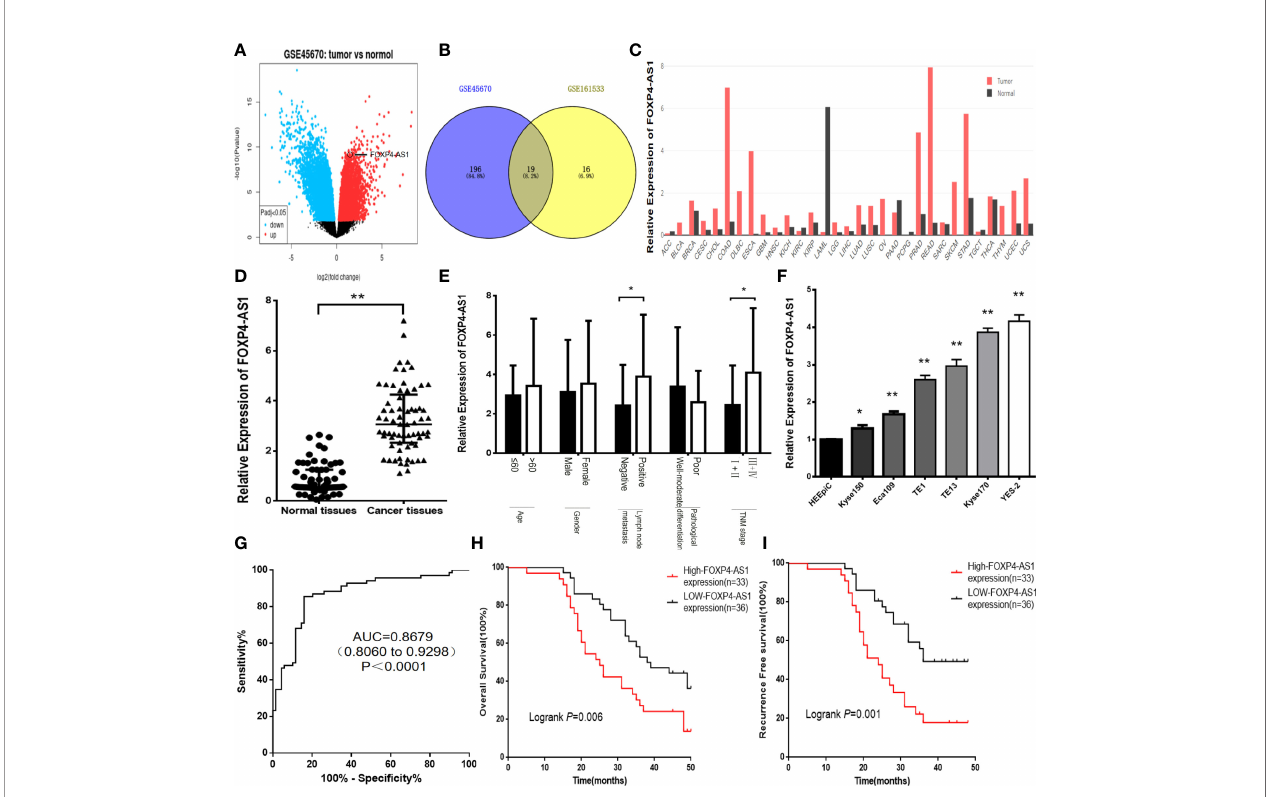
FIGURE 1 | FOXP4-AS1 is upregulated in ESCC and correlates with clinicopathological data. (A) The differentially expressed lncRNAs in GSE45670 by the volcano plots (log2|FC|>1). (B) Highly expressed lncRNAs in GSE45670 and GSE161533. (C) FOXP4-AS1 expression in various tumors by GEPIA dataset. (D – F) The expression of FOXP4-AS1 in ESCC tissues, different subgroups and cell lines by qRT – PCR. (G) ROC analysis shows an AUC of 0.8679 for differentiating ESCC from normal tissue. OS (H) and RFS (I) of ESCC patients according to FOXP4-AS1 by Kaplan – Meier analysis. * p < .05 and ** p <